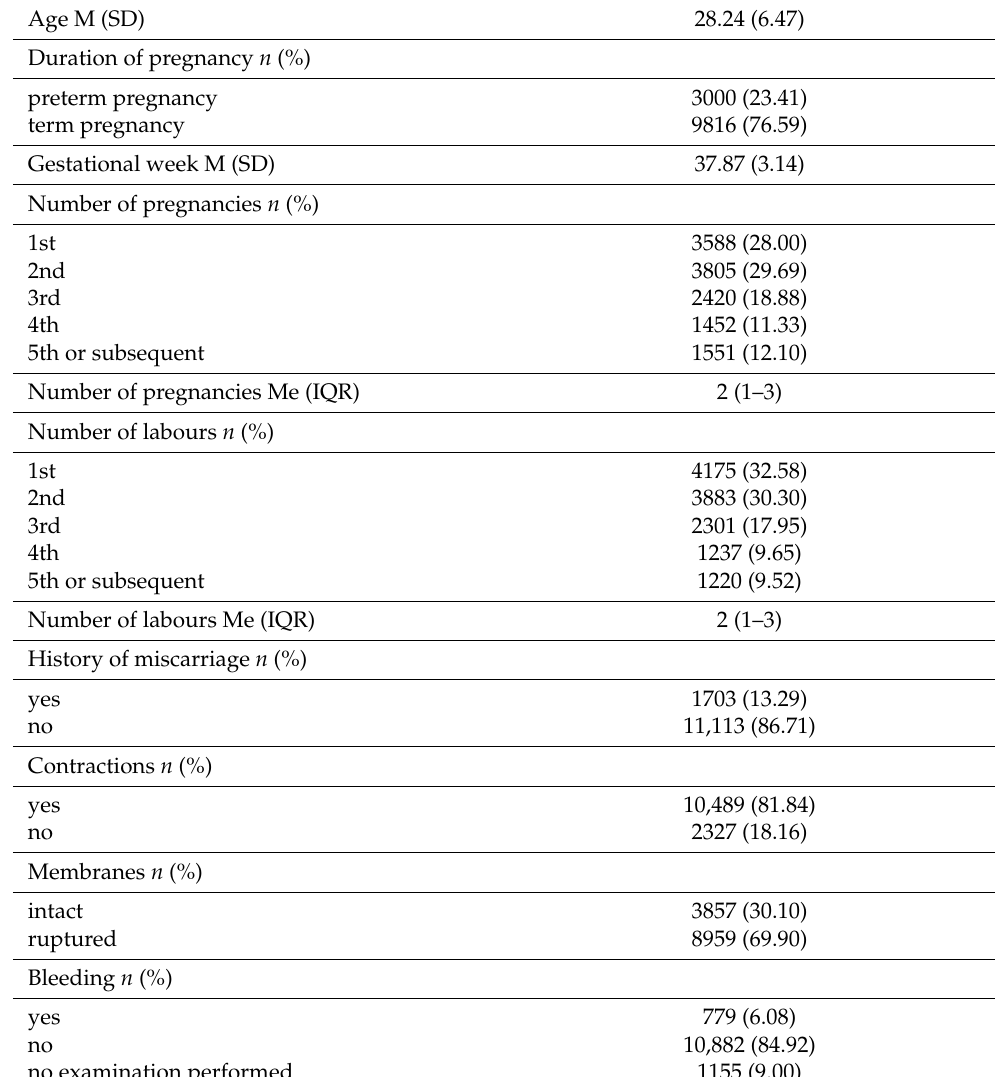
Table 1. Characteristics of pregnant patients attended by EMS